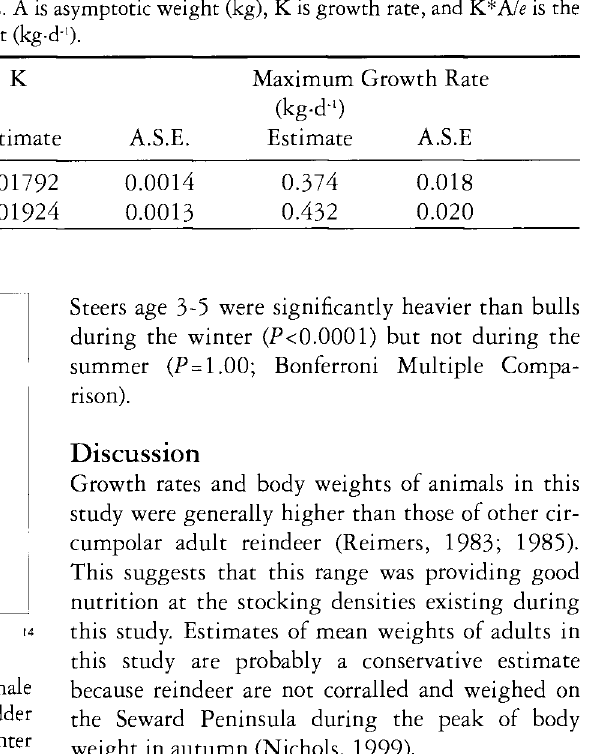
Fig. 3- Summer and winter body weights (+.f^) of female reindeer based on presence or absence of an udder during summer handlings. "W" indicates winter